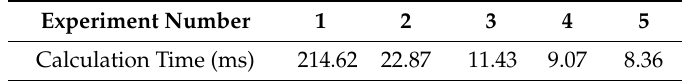
Table 1. The computation time for a single time step in five parallel experiments.